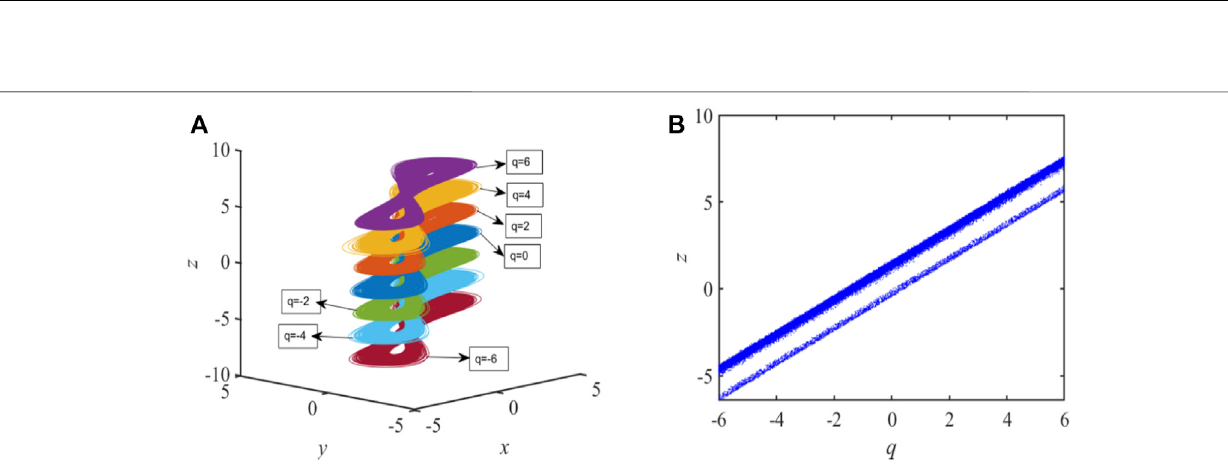
FIGURE 7 | (A) The attractor at different offsets q (B) bifurcation